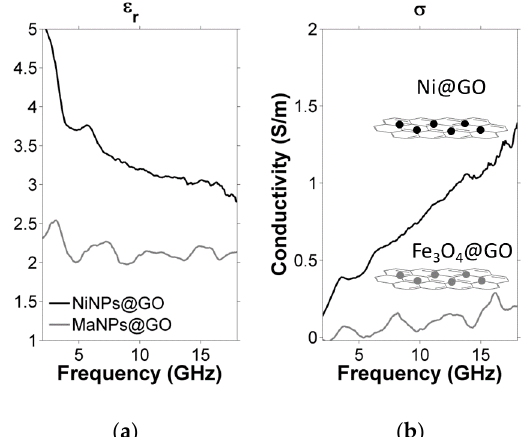
Figure 11. ( a ) Comparison of electrical parameters ε r ( a ) and σ ( b ) for nickel (Ni) and magnetite loaded at 30% on graphene oxide (GO).